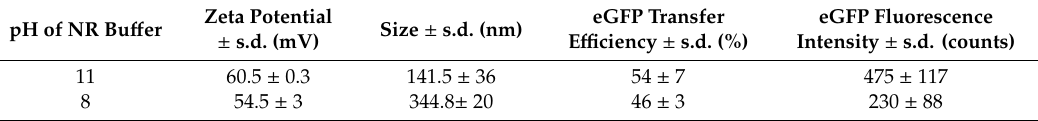
Table 3. E ff ect of pH on NR / NA / FL (neutralization reagent / nucleic acid / fusogenic liposome)-complex characteristics. Shown are the zeta potentials, the sizes of the protamine / eGFP–mRNA / FL complexes at two di ff erent pH values, as well as the resulting fusion and transfer e ffi ciencies after treatment of Chinese hamster ovary (CHO) cells. Values are given as mean with standard deviation (s.d.) of six (zeta potential), respectively, five (size) measurements. All values for pH 8 and pH 11 are significantly di ff